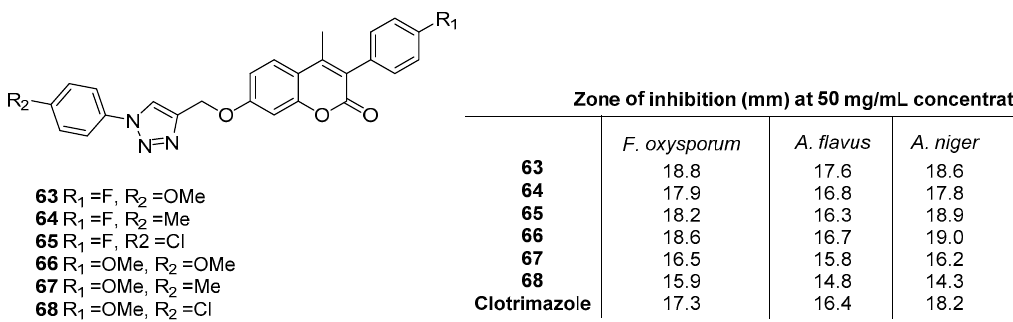
Figure 26. Coumarin-based 1,4-disubstituted 1,2,3-triazole derivatives.